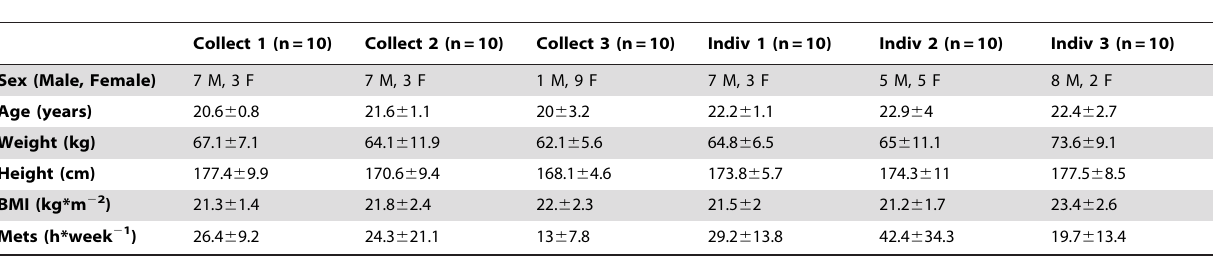
Table 1. Anthropometric data of the study